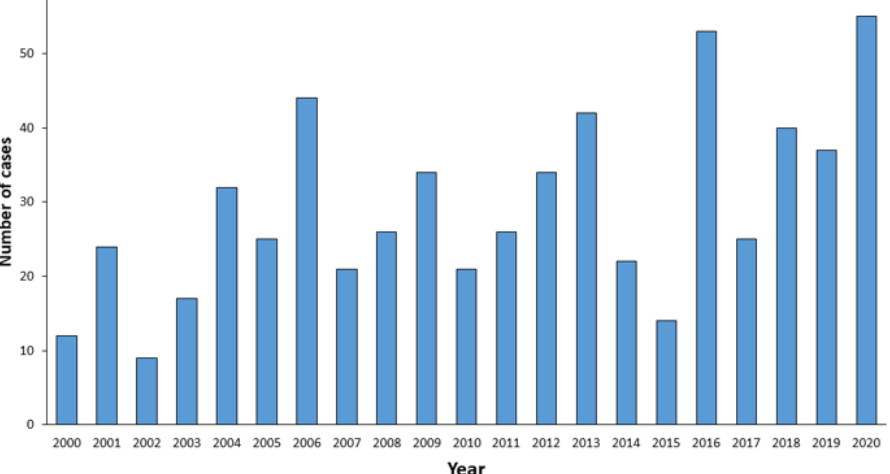
Figure 3. Annual number of TBE cases reported in Italy from 2000 to 2020 (Adapted from ref. [27]).